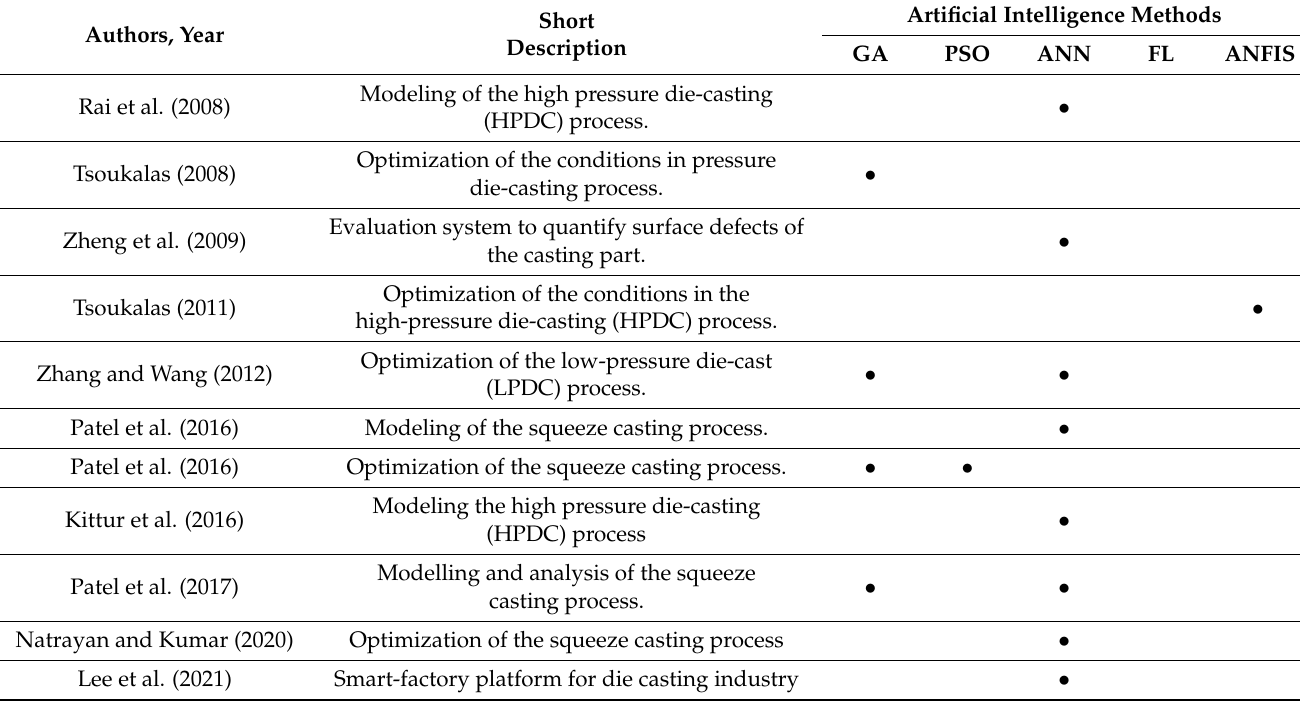
Table 2. Artificial intelligence methods used for the improvement of the die-casting